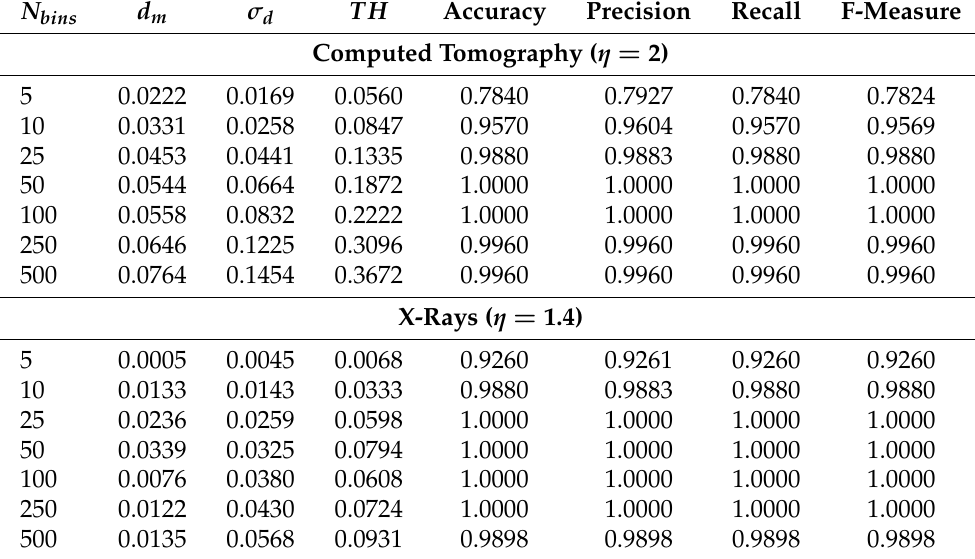
Table 6. Results obtained by the proposed approach for different number N bin of histogram bins. The reported performance metrics refer to the cosine distance at N T = 500 reference